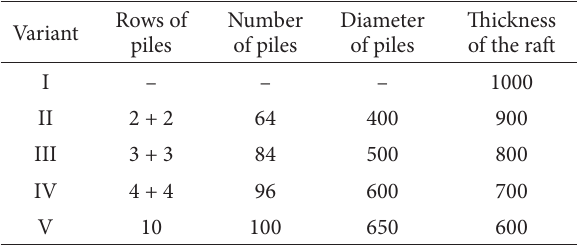
table 1. Variants of dimensions (mm) of piles and rafts Rows of Number Diameter Variant piles of piles of piles